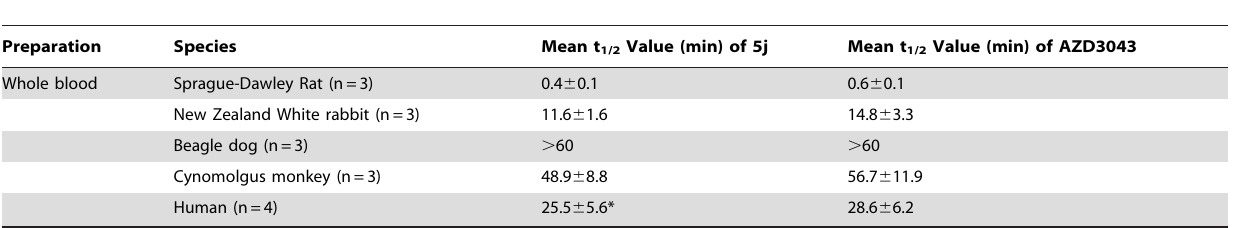
Table 5. The in vitro stability of 5j and AZD3043 in various